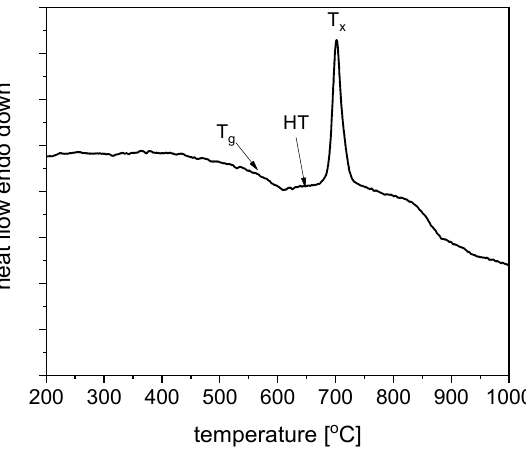
Figure 6. DSC curve of fabricated GGK with 15ZnO glass with heating rate 10 °C/min.